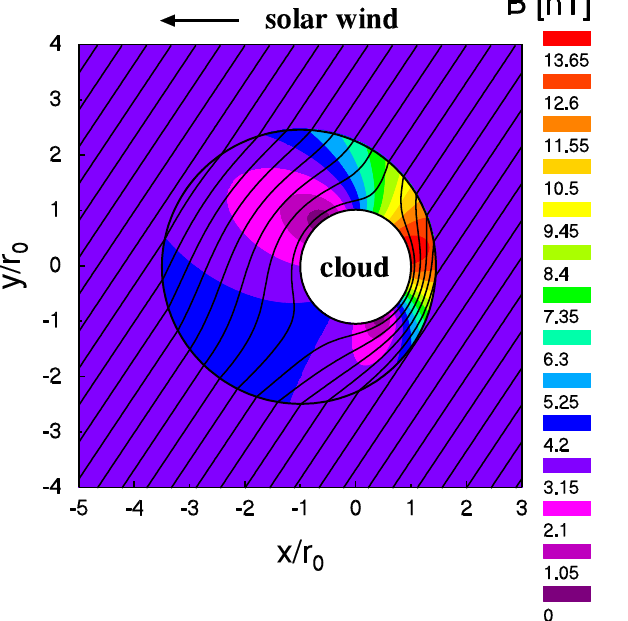
Fig. 3. Contours of | B | and field lines around the cloud.